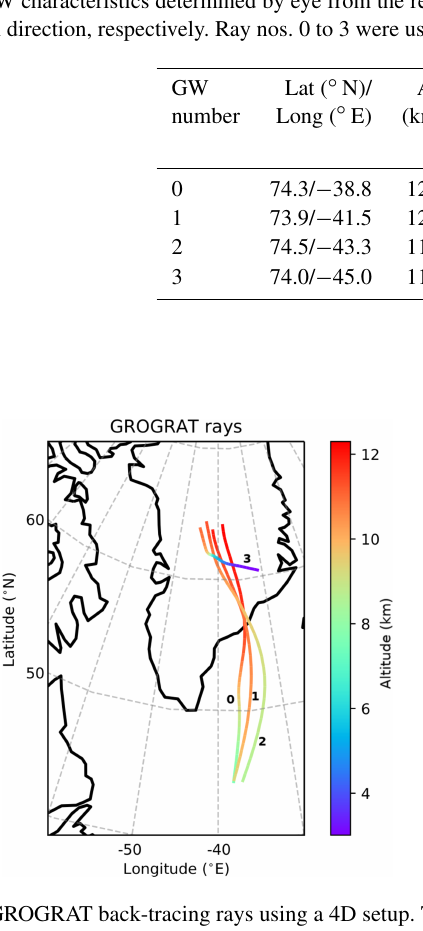
Figure 4. GROGRAT back-tracing rays using a 4D setup. The rays have a starting time of 10 March 2016 at 18:00UTC. The initial conditions for the rays are listed in Table 1. The back tracing starts between 11 and 12.3km and is depicted with respect to altitude, latitude and